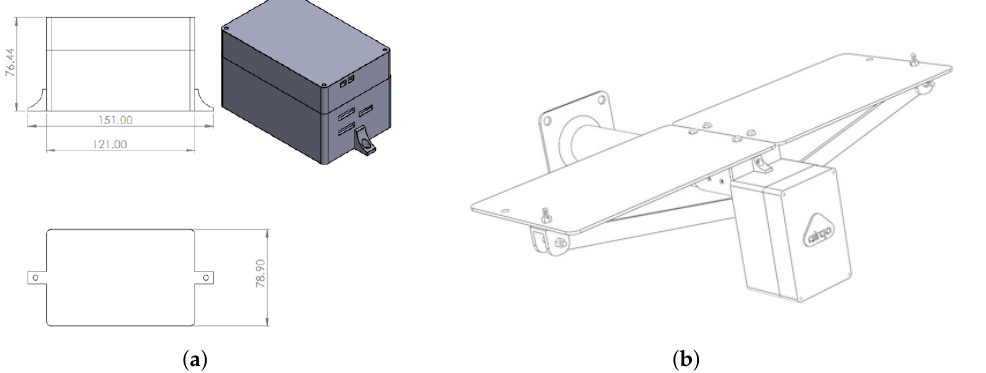
Figure 2. A design of a portable low-cost air quality monitor. ( a ) AirQo monitor. ( b ) AirQo solar